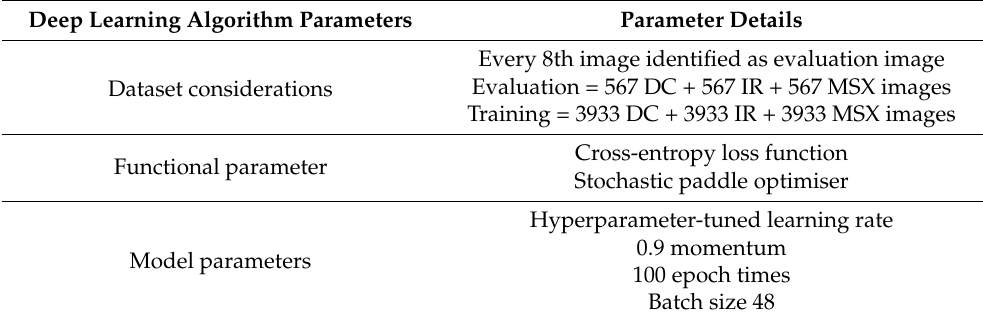
Figure 4. Architecture of the proposed CNN model. Table 1. Deep learning algorithm—experimental setup and parameters.